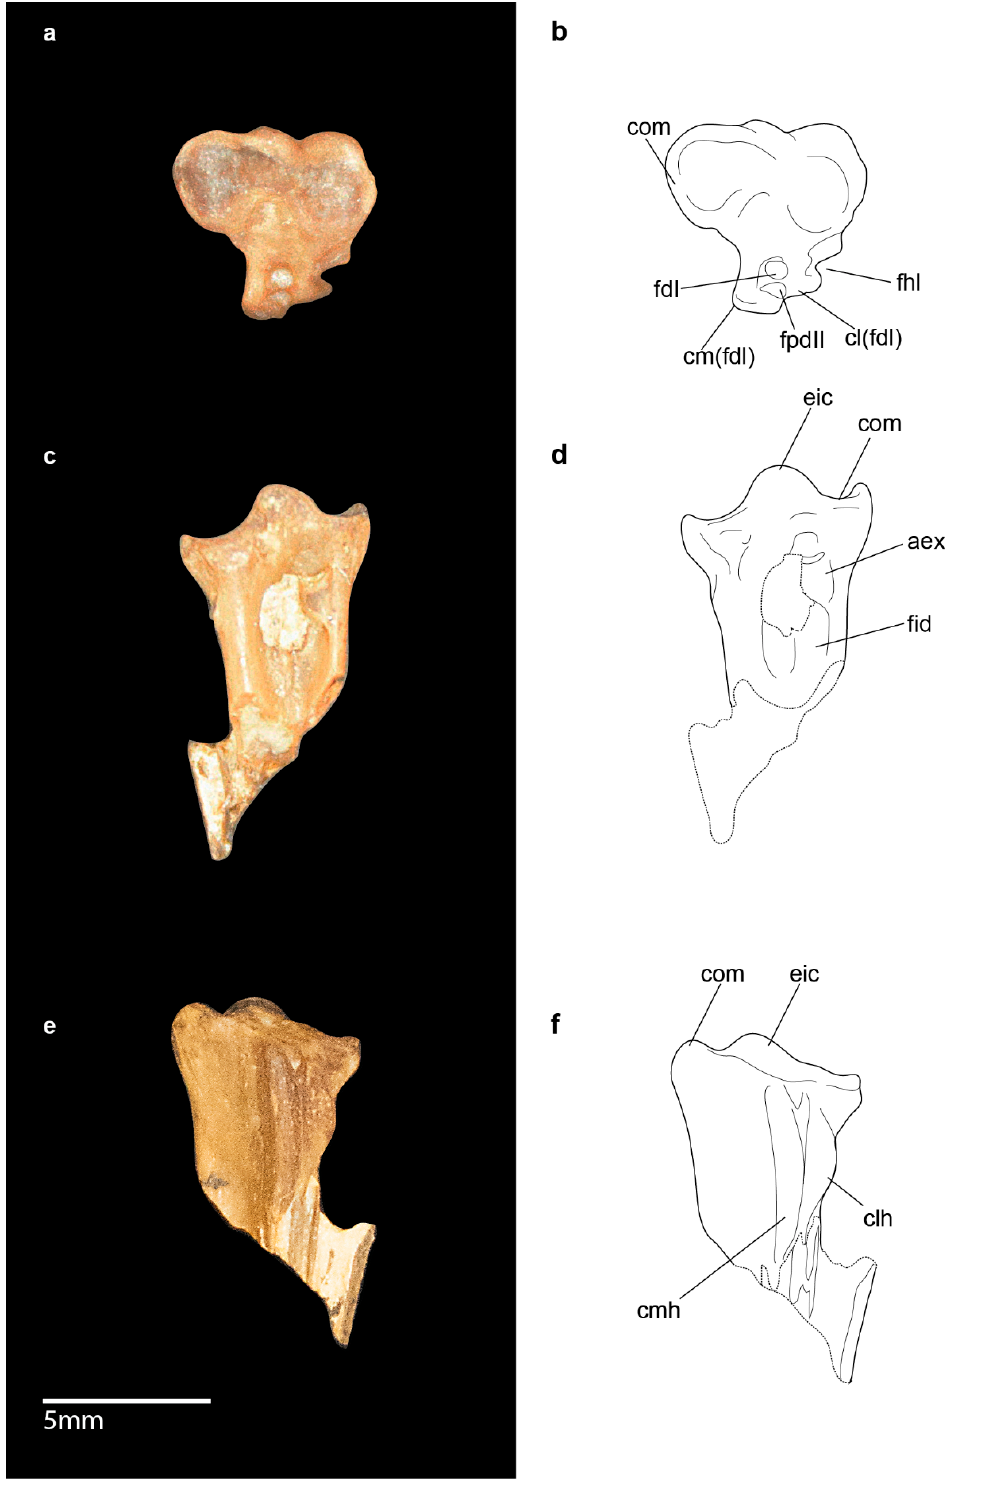
Figure 4. Photographs ( a, c, e ) and line drawings ( b, d, f ) of the right tarsometatarsus of referred Pellornis mikkelseni specimen, DK664 in proximal, dorsal, and ventral aspect. Anatomical abbreviations: eic eminentia intercotylaris, com cotyla medialis, aex arcus extensorius (ossified retinaculum), cl(fdl) crista lateralis flexoris digitorum longus, cm(fdl) crista medialis flexoris digitorum longus, fdl canal for m. flexor digitorum longus, fpdII canal for m. flexor perforates digiti II, fhl sulcus for m. flexor hallucis longus, fid fossa infracotylaris dorsalis. The scale bar applies to all views.